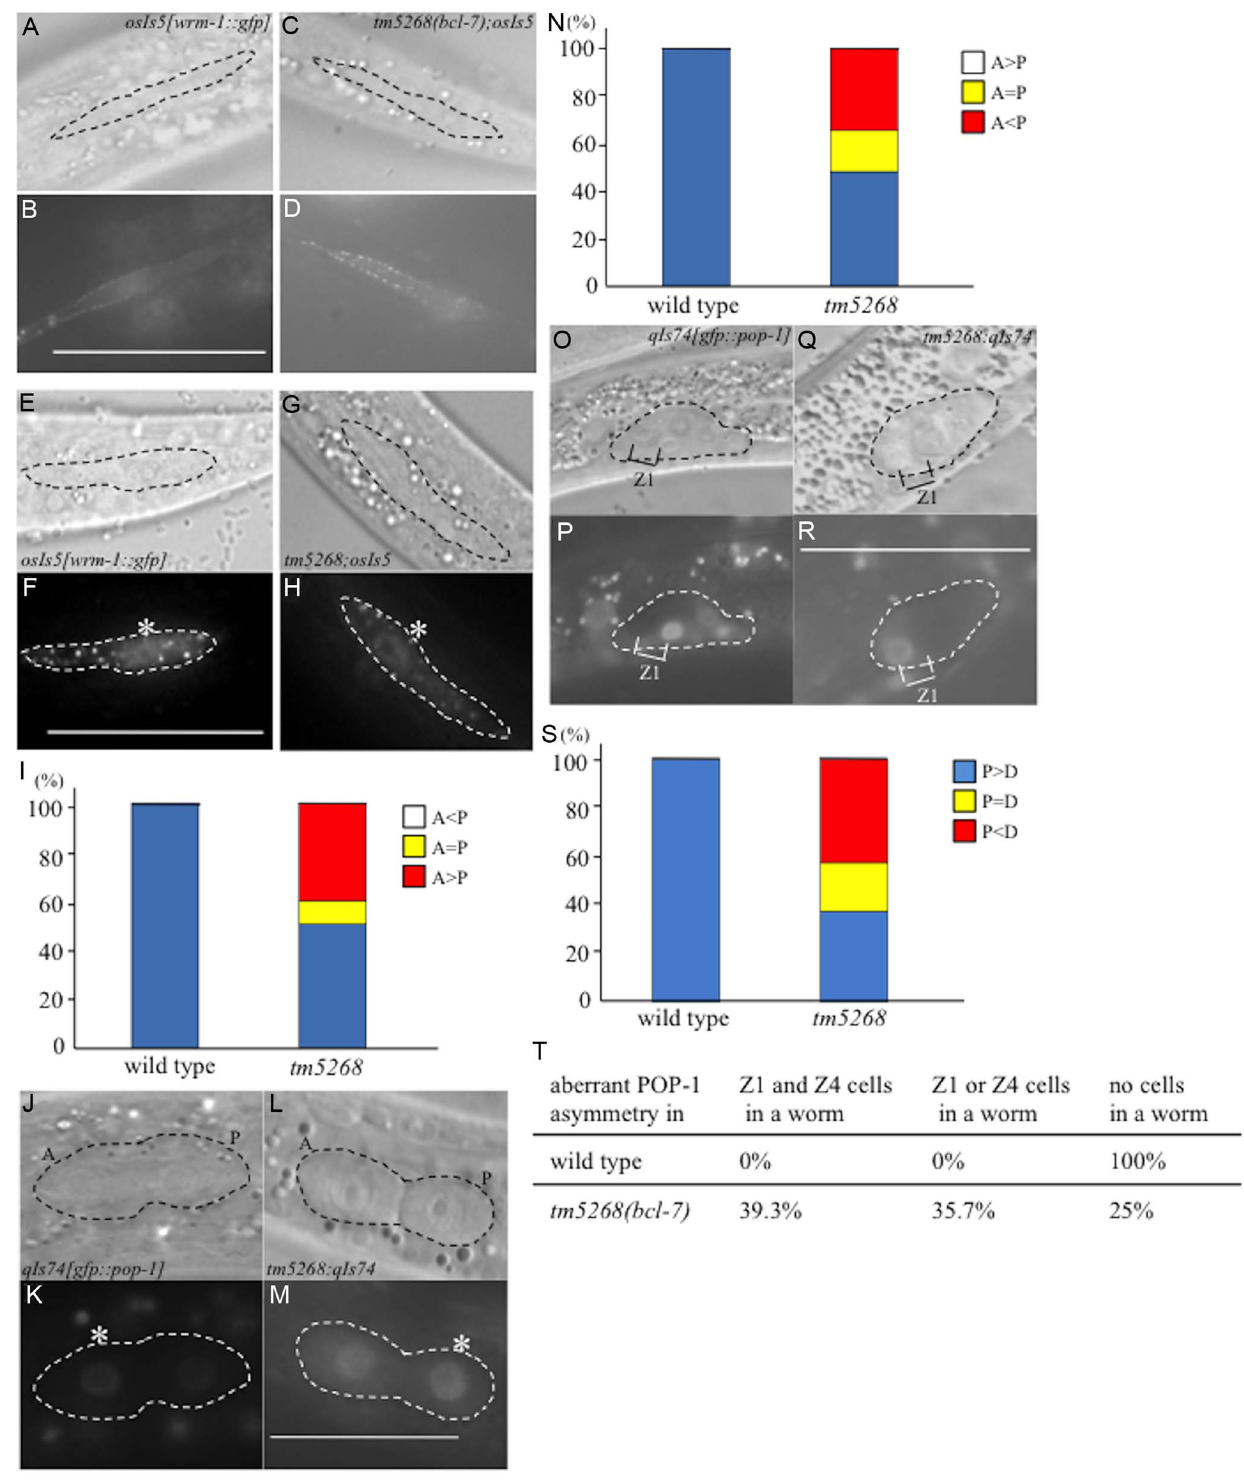
Fig. 5. BCL-7 is involved in the asymmetric localization of Wnt components in Caenorhabditiselegans . A–D : Nomarski ( A, C ) and GFP ( B, D ) images of wild type ( A, B ) and tm5268 ( C, D ) L2-stage hermaphrodites carrying a wrm-1::gfp reporter ( osIs5 ) at pre-division states. Seam cells are traced with dotted ovals ( A, C ). E–H : Nomarski ( E, G ) and GFP ( F, H ) images showing the localization of WRM-1::GFP in two daughter cells of wild- type or tm5268 L2 hermaphrodites at post-divisions. The pairs of daughter cells are outlined with dotted ovals. I : Frequency of the localization patterns of WRM-1::GFP. The equal and unequal signs indicate the relative intensities of nuclear WRM-1::GFP between two daughter cells. J–M : Nomarski ( J, L ) and GFP ( K, M ) images showing the localization of GFP::POP-1 ( qIs74 ) in two daughter cells of wild-type ( J, K ) or tm5268 ( L, M ) L1 hermaphrodites in post-division states. The pairs of daughter cells are outlined with dotted ovals. Asterisks indicate nuclei with stronger expression of GFP. N : The frequency of the localization patterns of GFP::POP-1. The equal and unequal signs indicate the relative intensities of nuclear GFP::POP-1